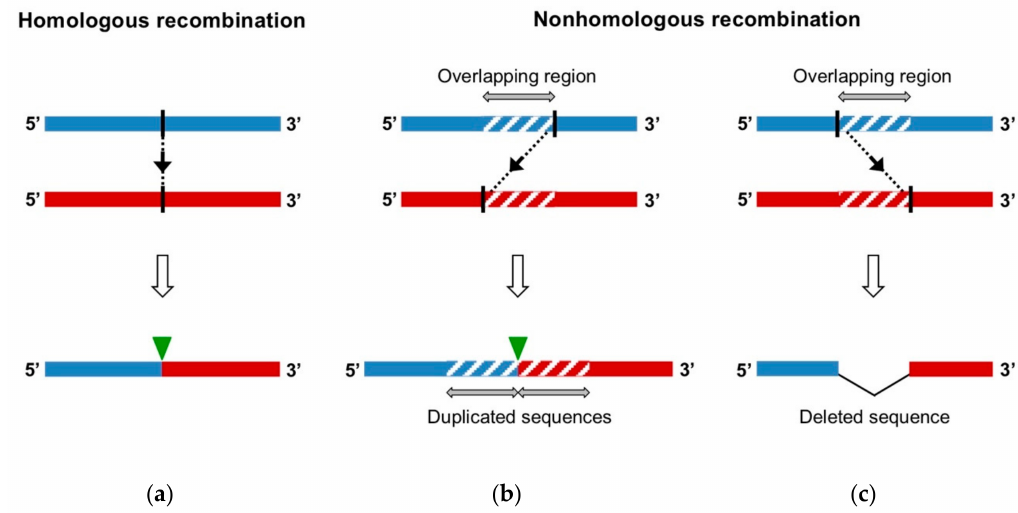
Figure 2. Homologous and nonhomologous recombinant genomes. Parental RNA genomes are located in the upper panel of ( a ), ( b ) and ( c ) diagrams. They have a similar genomic structure. The recombination site in each of the parental genomes is represented by a black vertical line, the recombination event is indicated by black dotted line and arrow. The recombination site in the obtained recombinant genome (lower panels) of ( a ) and ( b ) diagrams is indicated by a green reversed triangle. ( a ) Homologous recombination occurs at the same site in both parental genomes, thus the obtained recombinant has the same genomic structure as the parental viruses. ( b ) and ( c ) Nonhomologous recombination occurs at di ff erent sites in the two parental genomes. ( b ) a duplication of homologous sequences (hatched) is generated around the recombination site. ( c ) A deletion of genomic sequence is